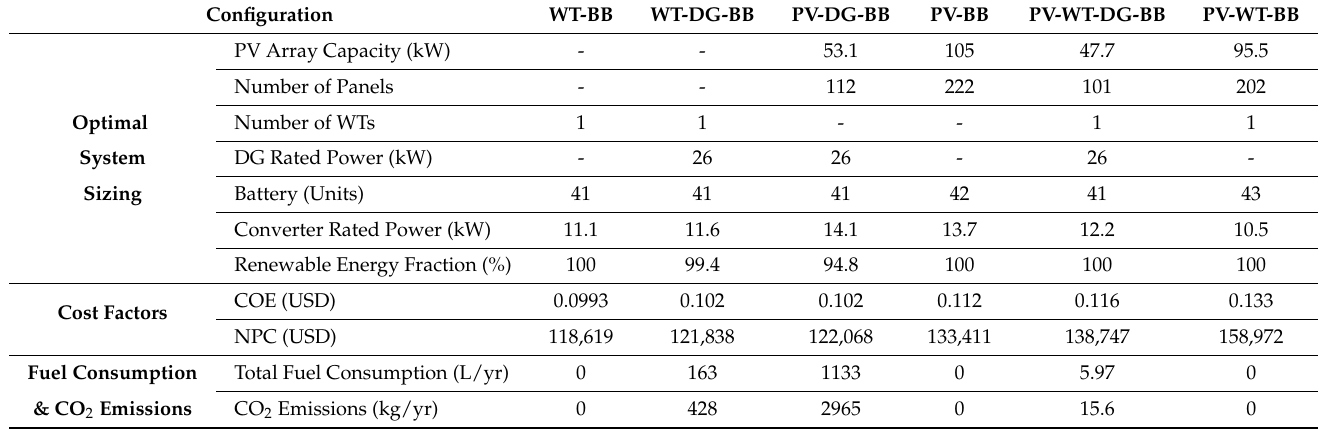
Table 13. Simulation Results for Jal-Alayah Cell Site—Case 4.